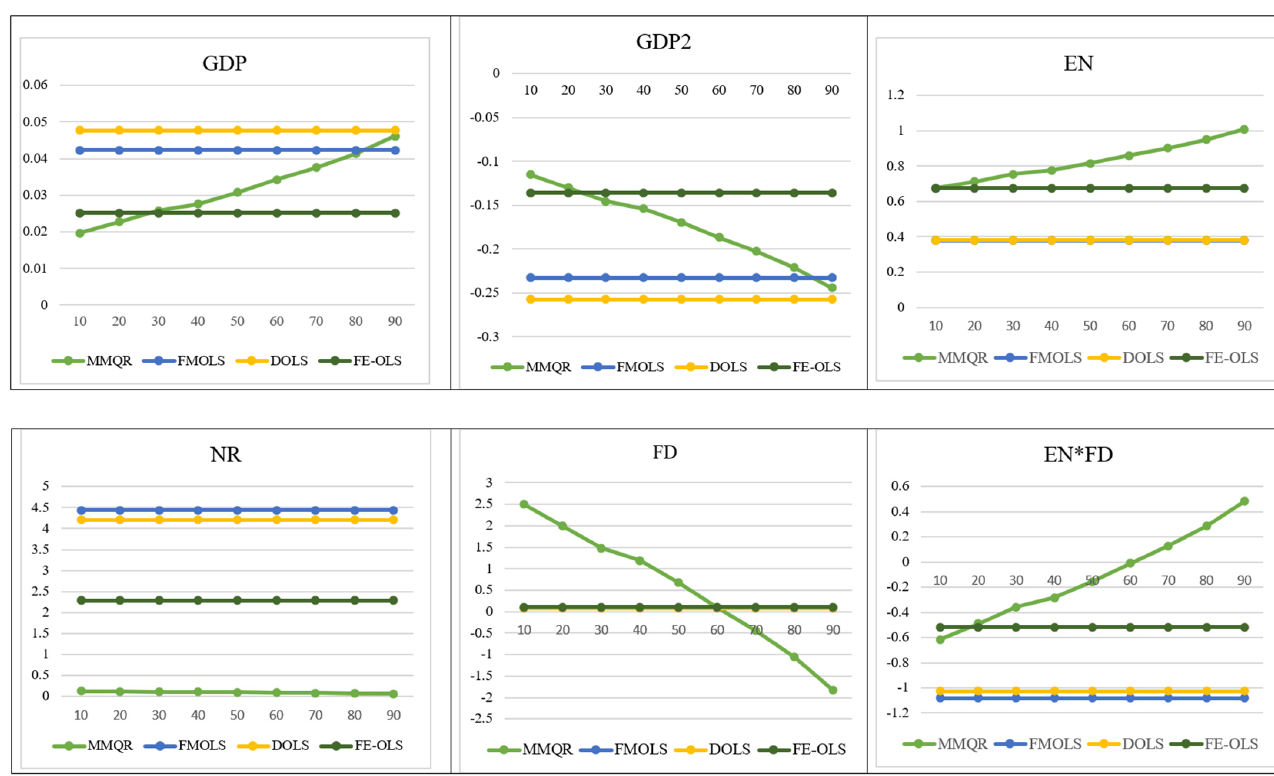
Figure 2. Results of the comparison of the three estimators and MMQR.